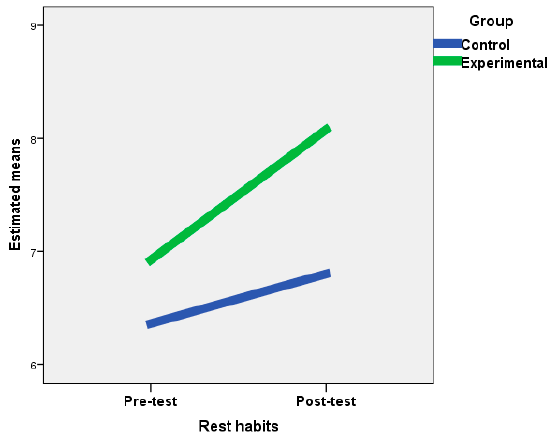
Figure 1. Changes in rest habits for the experimental and control groups after the intervention.